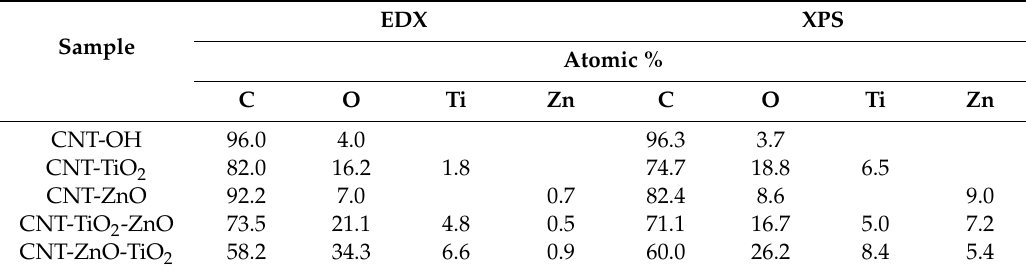
Table 2. Elemental composition from EDX and XPS measurements.